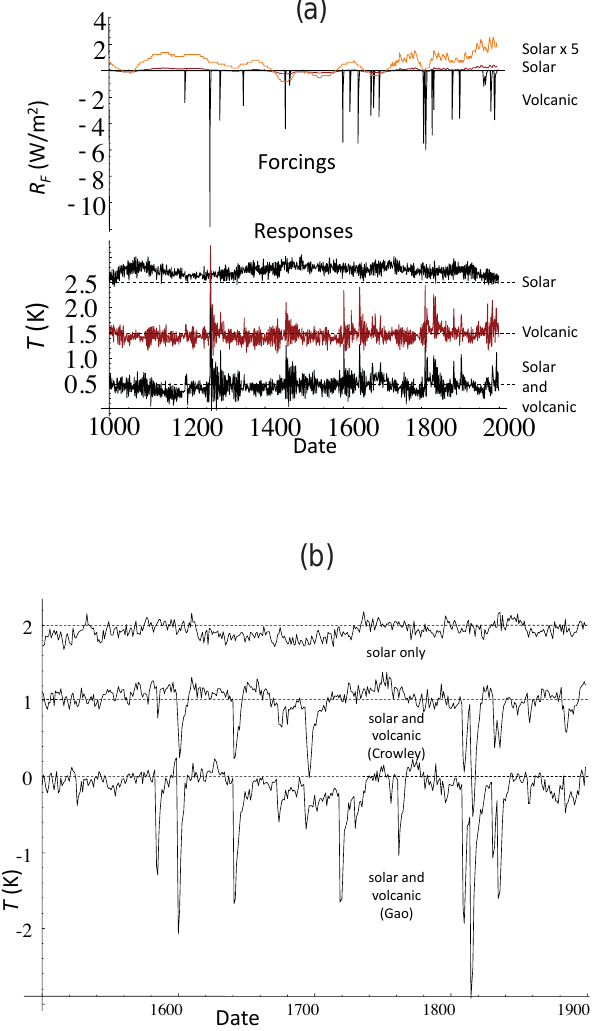
Figure 1. (a) Top graph: the radiative forcings R F (top, Wm 2 ) and responses T (K) from AD1000 to 2000 for the Zebiak–Cane model, from Mann et al. (2005), integrated over the entire simulation re- gion. The forcings are reconstructed solar (brown), solar blown up by a factor 5 (orange) and volcanic (black). For the solar forcing (top series), note the higher-resolution and wandering character for the recent centuries – this part is based on sunspots, not 10 Be. Bot- tom graph: the responses are for the solar forcing only (top), vol- canic forcing only (middle) and both (bottom); they have been off- set in the vertical for clarity by 2.5, 1.5, and 0.5K, respectively. (b) GISS-ER-2 responses averaged over land (the Northern Hemi- sphereonly) at annual resolution. The industrial part since 1900 was excluded due to the dominance of the anthropogenic forcings. The solar forcing is the same as for the ZC model and is sunspot-based since 1610. The top row is for the solar forcing only, the middle se- ries is the response to the solar and Crowley reconstructed volcanic forcing series (i.e. the same as used in the ZC model), and the bot- tom series uses the solar and reconstructed volcanic forcing series from Gao et al. (2008). Each series has been offset in the vertical by 1K for clarity (these are anomalies, so the absolute temperature values are